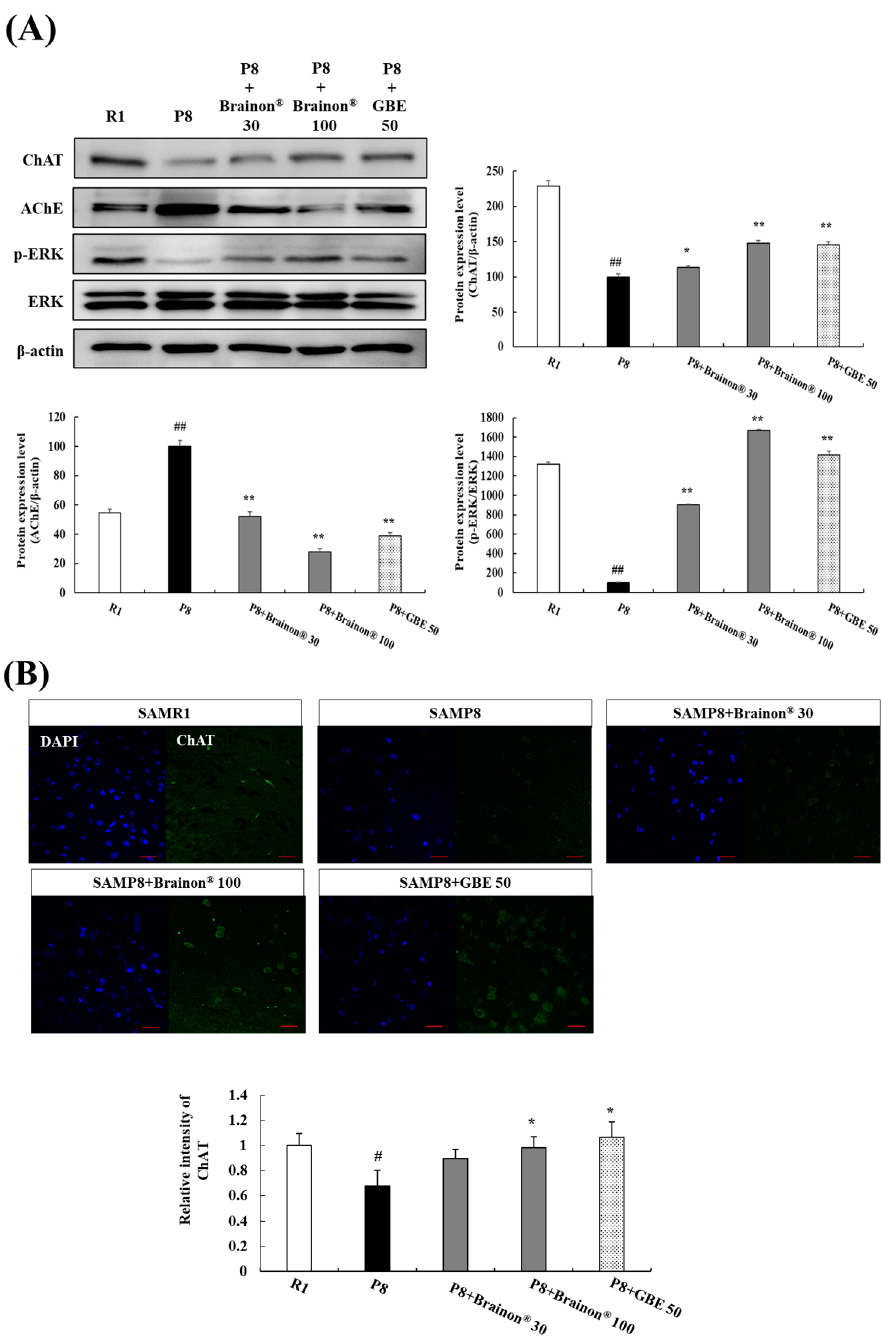
Figure 11. Brainon ® regulates the expressions of AChE and ChAT and the phosphorylation of ERK in the hippocampus of SAMP8 mice. ( A ) ChAT (71 kDa), AChE (68 kDa), p-ERK (42–44 kDa), and ERK (42–44 kDa) protein levels were analyzed using Western blotting. The density of each protein band was determined using the ImageJ program. Protein was normalized using β -actin (45 kDa). ( B ) Immunofluorescence staining of ChAT in the hippocampus of mice brain (×20 magnification). The density of ChAT staining was assessed with the ImageJ program and statistically analyzed by GraphPad Prism. Values are presented as mean ± SD ( n = 3). # p < 0.05 and ## p < 0.01 vs. R1 (SAMR1) group; * p < 0.05 and ** p < 0.01 vs. P8 (SAMP8) group.